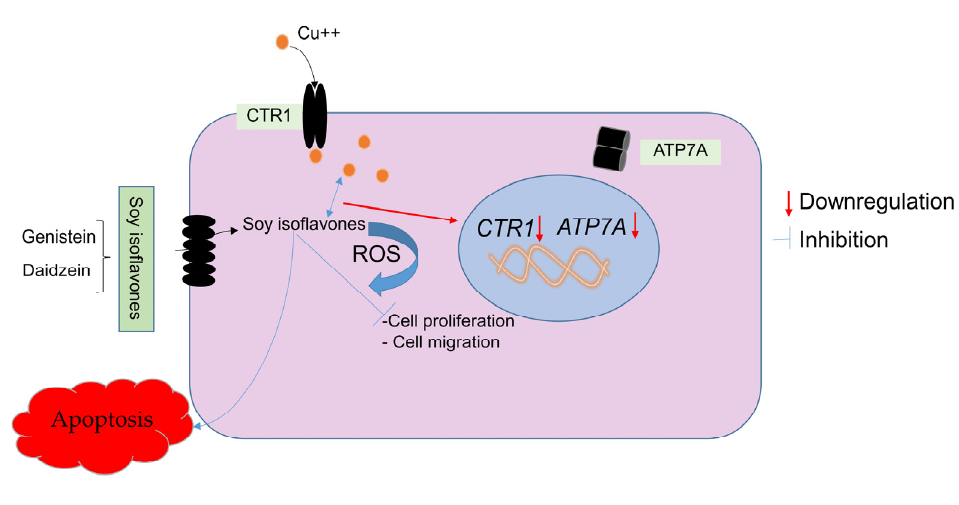
Figure 10. A proposed schematic diagram showing the interaction of iso fl avones and copper in the down-regulation of CTR1 and ATP7A . In addition, the involvement of redox cycling generates reactive oxygen species, leading to DNA damage and, ultimately, apoptosis.